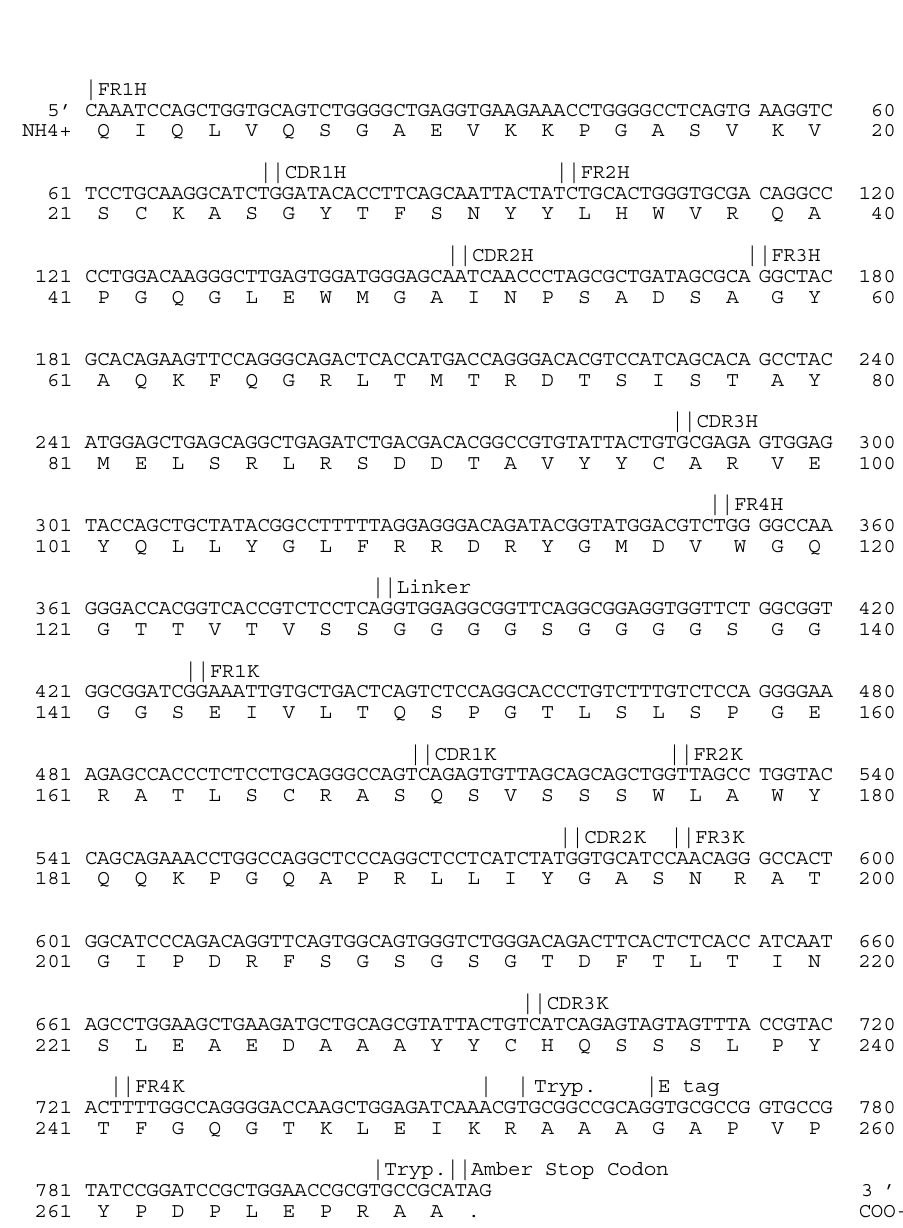
Figure 3. Deduced amino acid sequence of variable domains of heavy and light chains of the anti-VACV 1.2.2.H9 ( A ) and 1.4.1.C4 ( B ).